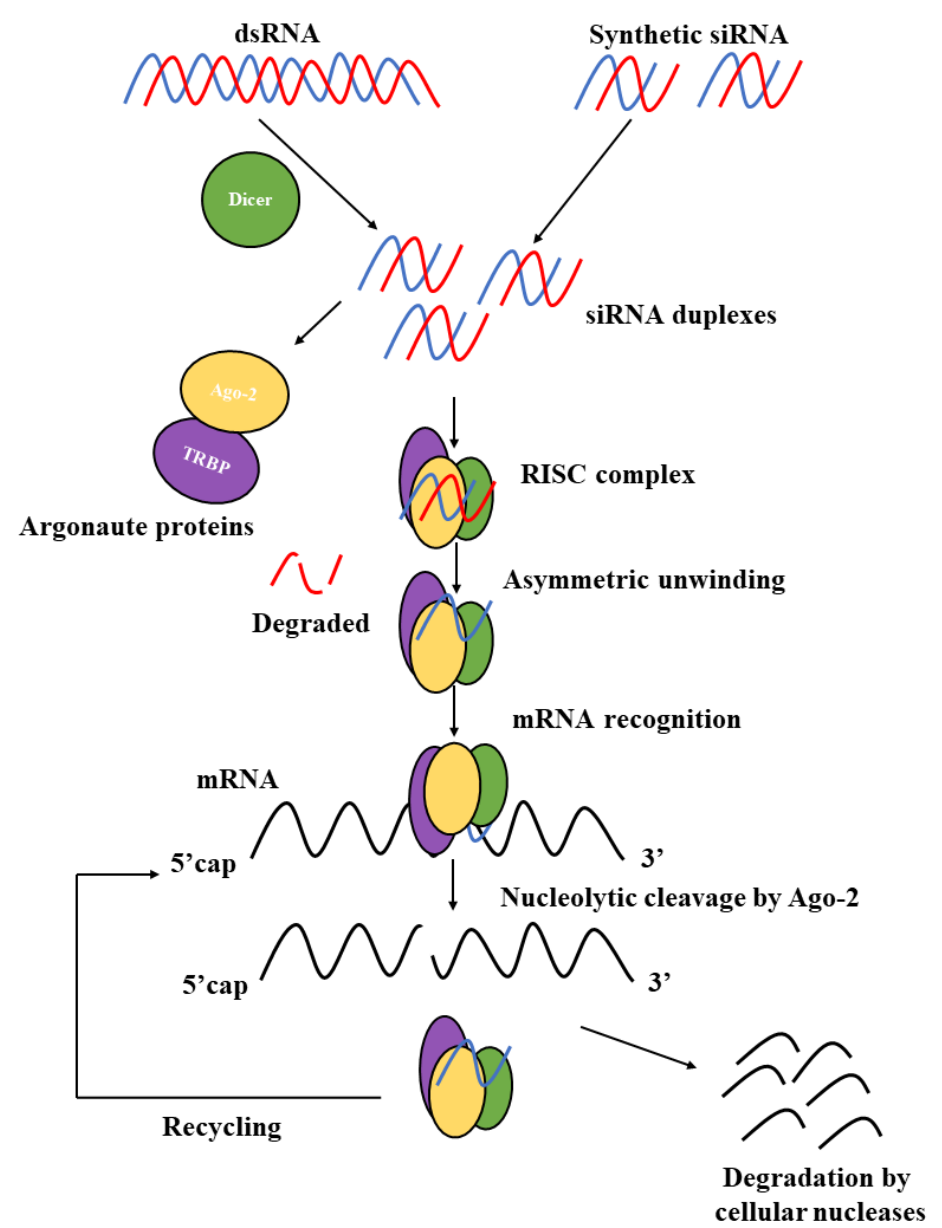
Figure 5. Schematic illustration of the mechanism of gene silencing by double-stranded RNAs